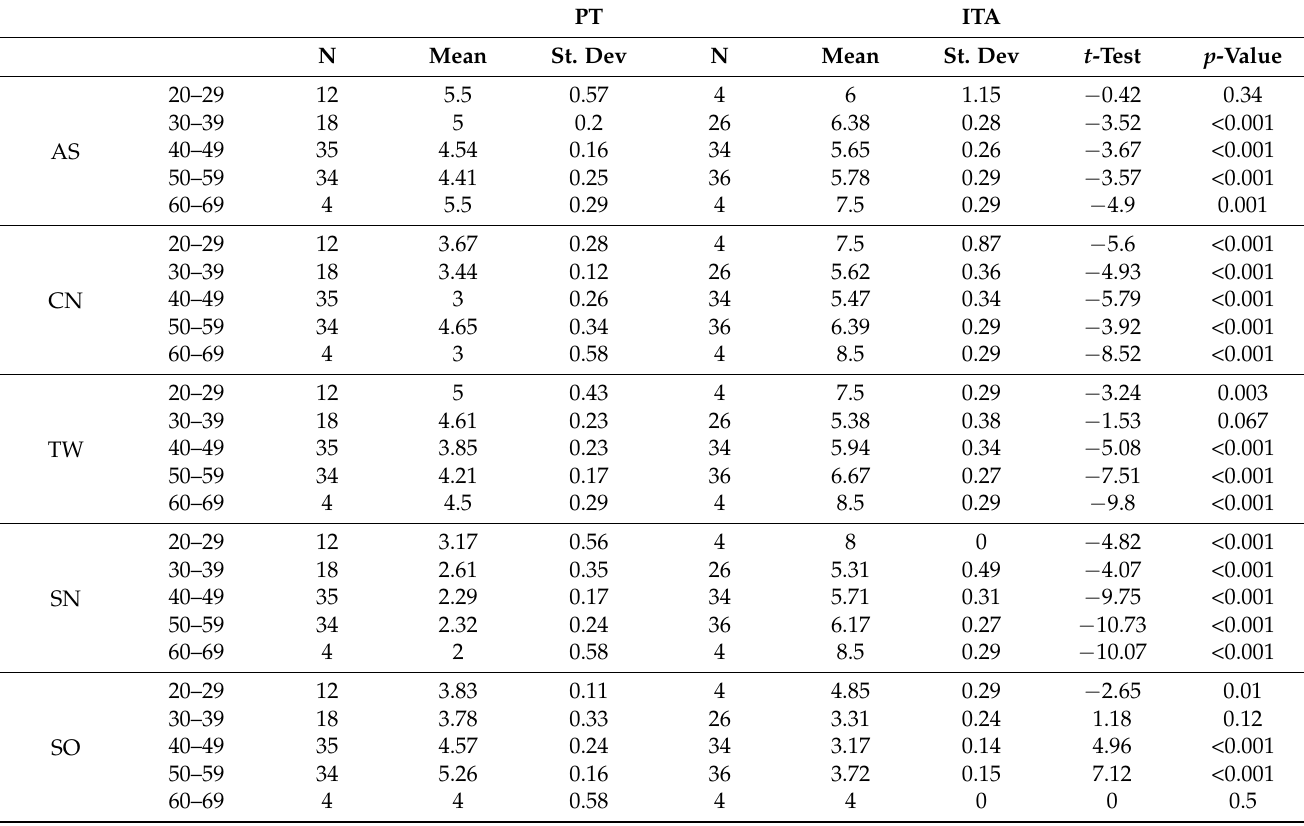
Table 3. Self-assessment of age-related